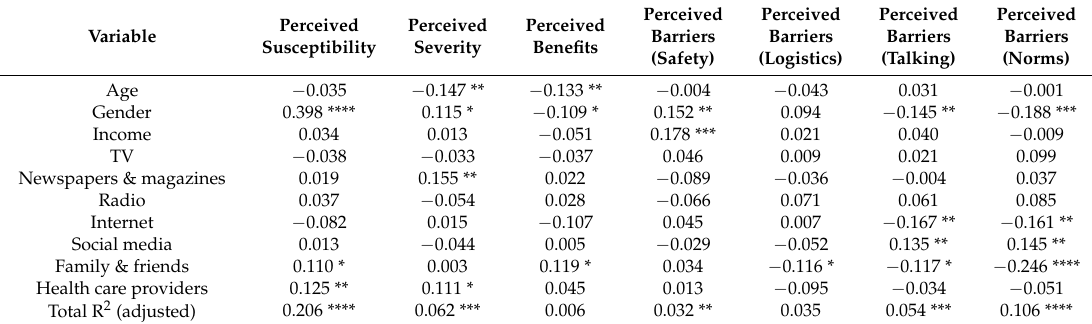
Table 4. Results of Multiple Regressions for Research